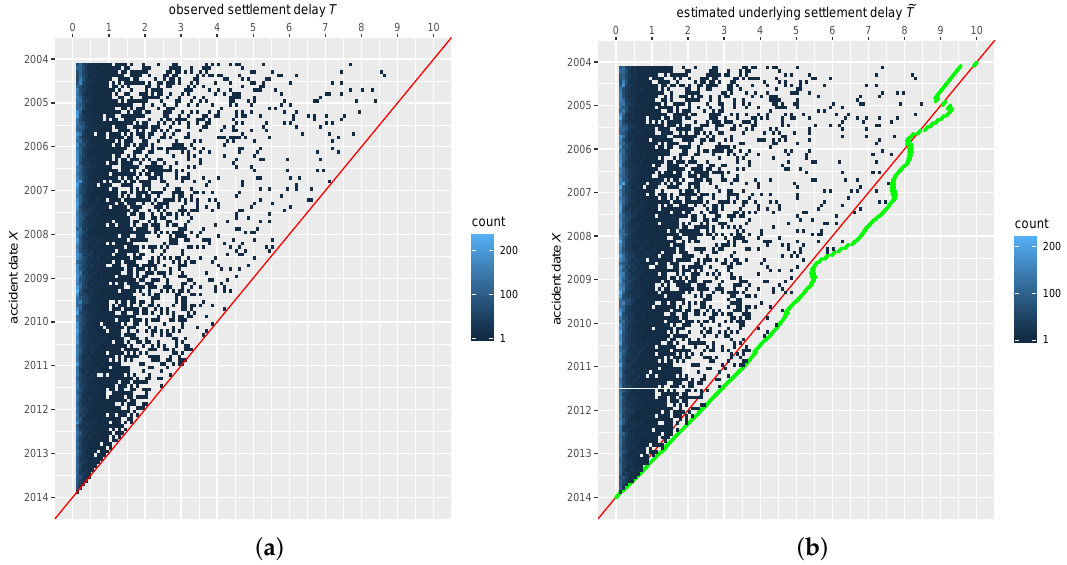
Figure 1. Original data and data with unobservable delay (cid:101) T cleared of operational time. The operational time in ( b ) is estimated in Section 6. Claim counts are aggregated into monthly bins for visualization, and settlement delay is displayed in years. The red line represents the date of data collection and the green points are the date of data collection cleared of operational time effects (with respect to accident date). ( a ) original data; ( b ) data cleared of operational